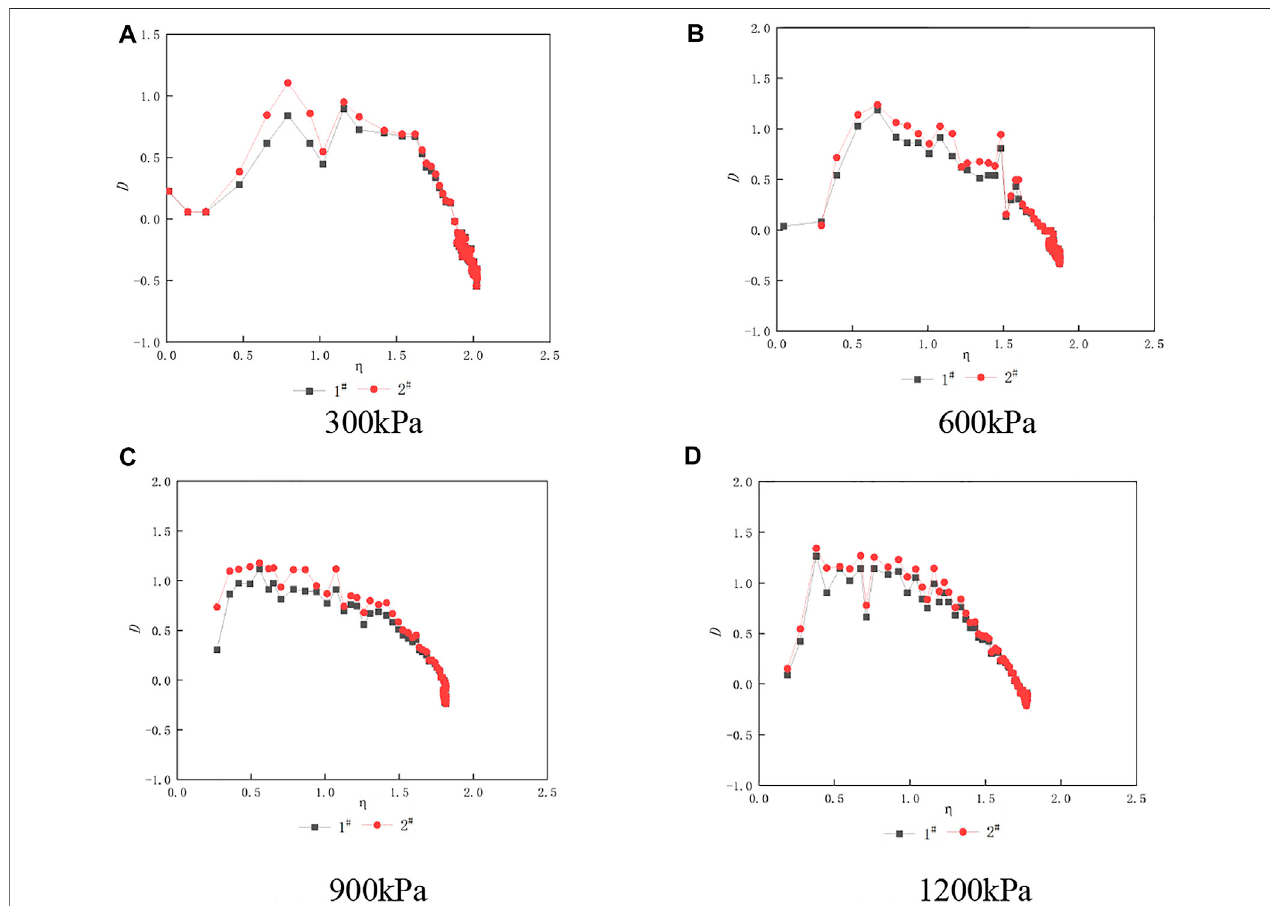
FIGURE11| ThedilatancyratioofLCSGmaterialwithcementedcontentof20kg/m3underdifferentcon fi ningpressures. (A) 300 kPa (B) 600 kPa (C) 900 kPa (D) 1,200 kPa.